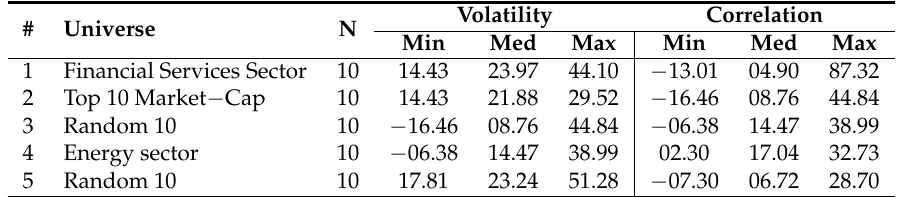
Table 1. List of universes constructed: N denotes the number of assets considered in each universe. The Min, Med, Max reports the minimum, median and maximum values of the unconditional volatilities, respectively, and the unconditional pairwise correlations in percentage for each